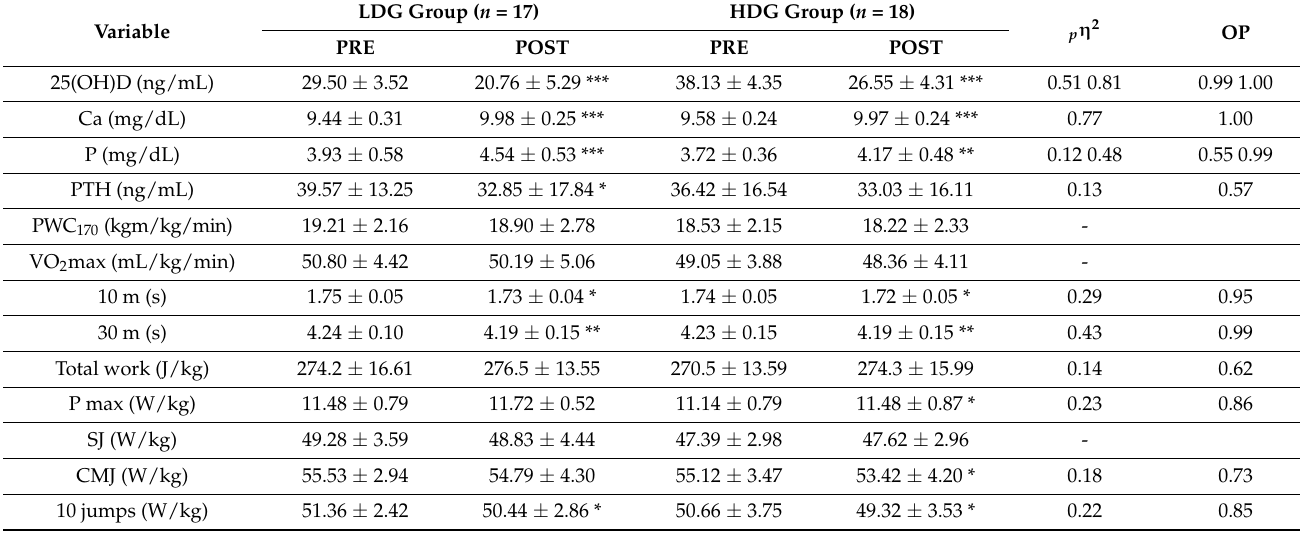
Table 3. Changes in selected blood biochemical and physical performance indicators in young footballers in the group with low 25(OH)D (LDG) concentration ( n = 17) and in the group with optimal 25(OH)D HDG concentration ( n = 18) before (PRE) and after (POST) testing program.